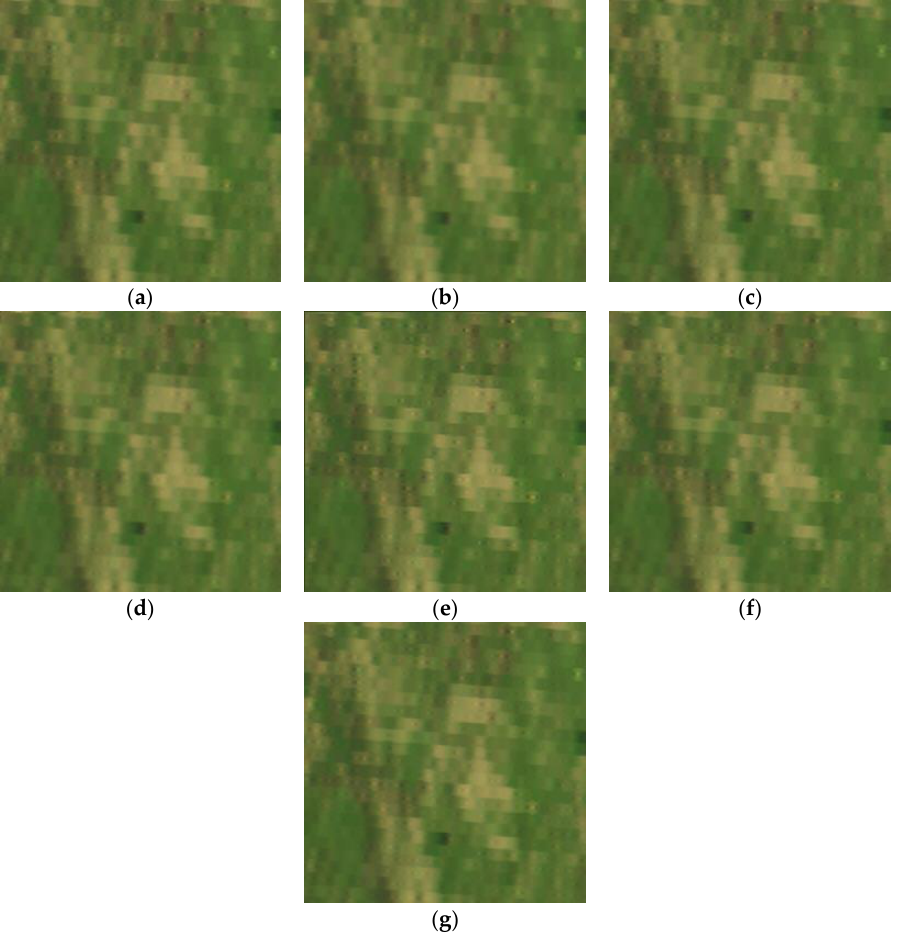
Table 3. Comparison results of A-PSNR, A-SSIM and SAM on Jinyin Tan dataset 1. Measures